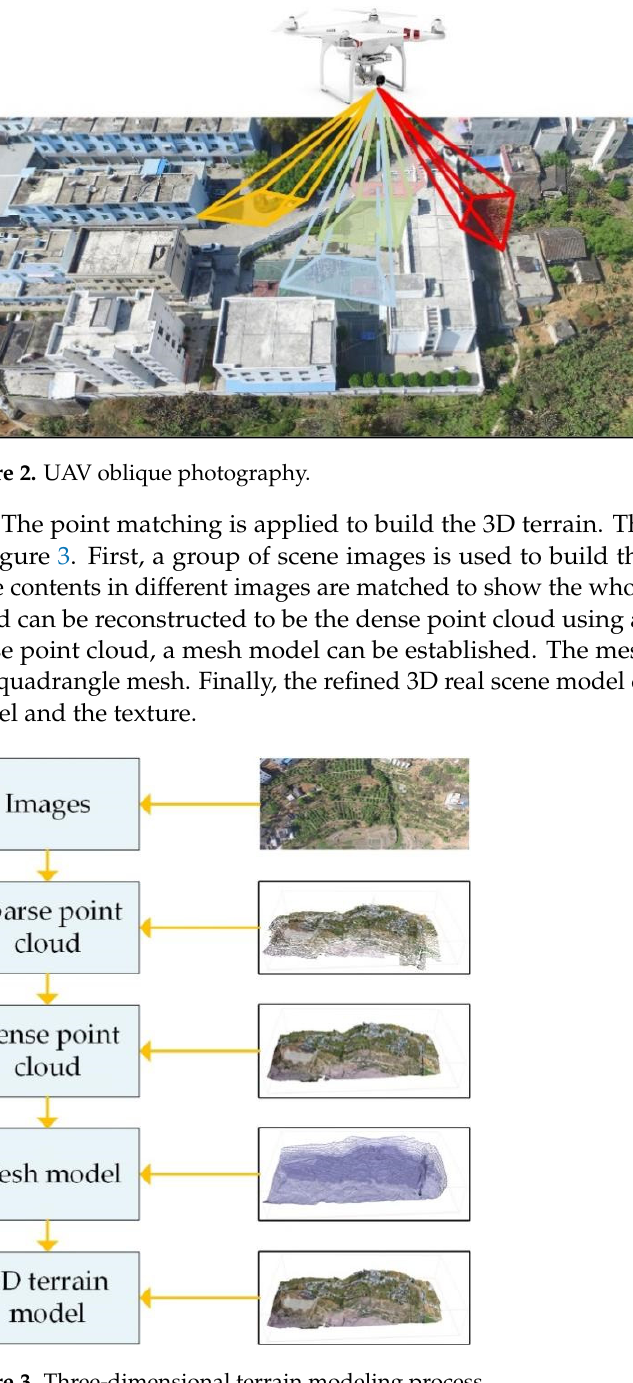
Figure 3. Three-dimensional terrain modeling process.